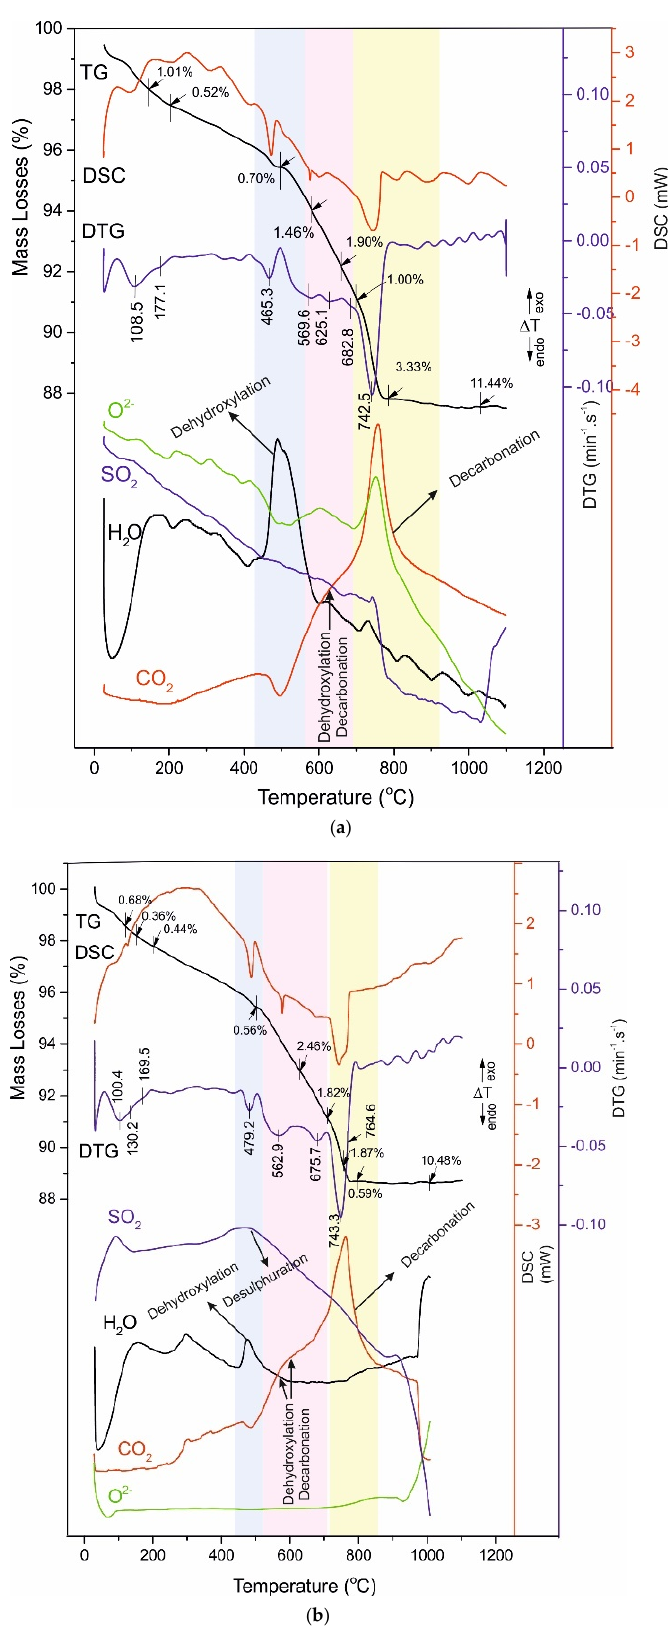
Figure 8. ( a ) TG-DTG-DSC curves of A028. ( b ) TG-DTG-DSC curves of A120. The temperature intervals in which thermal processes take place are marked with a different color background. In sample B, are registered CO 2 and OH - , and SO 2 (Figure 9). Sulphate- and carbonate- bearing minerals are stable at this temperature stage, which suggests that OH - , SO x , CO 2 , and O 2 − detection is of their realization from phases in which they are included as defects, situated in different crystallographic positions. These defects can be associated with weaker inter-/intra bonds at interlayer spaces and channel structures [62–64], leading to structural compaction and physical-mechanical properties improvement [19,65,66]. The CO 2 and OH - , and SO 2 evolving are most distinct in B028 and B120 but are also observed at C028 and C120 (Figure 10) being less pronounced, because of the presence of HRWR additive reducing the water-to-cement ratio. The dehydration-decarbonation reactions could also be attached to the III rd range. They occur with the carbonate ions realization from the hydrogen-carbonate phases (Ca- HCO 3 , mono/hemi-carboaluminates) which are meta-stable and decarbonize at lower temperatures than CaCO 3 . That explains the low-intensity peaks insertion into the major decarbonation peak of samples in the next temperature range of 730–850 °C. The presence of HCO 3 − /HSO 4 − explains the registration of hydroxyl and carbonate/sulphate ions in the evolving gas [67,68]. The НСО 3 − / СО 32 − equilibrium depends on the raw materials and en- vironment: humidity, temperature, sulphur, nitrogen, carbon-containing, and other gases, pH, etc. The change in the ratio of the phases containing НСО 3 − / СО 32 − and HSO 4 − /SO 42 − ions is carried out at the solid-gas (material-to-atmosphere) interphase boundary. These